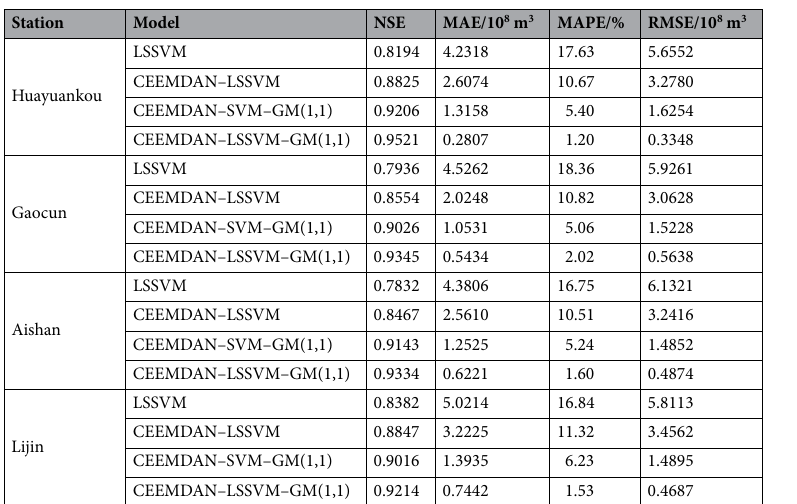
Table 1. Evaluation of the prediction results of each model.